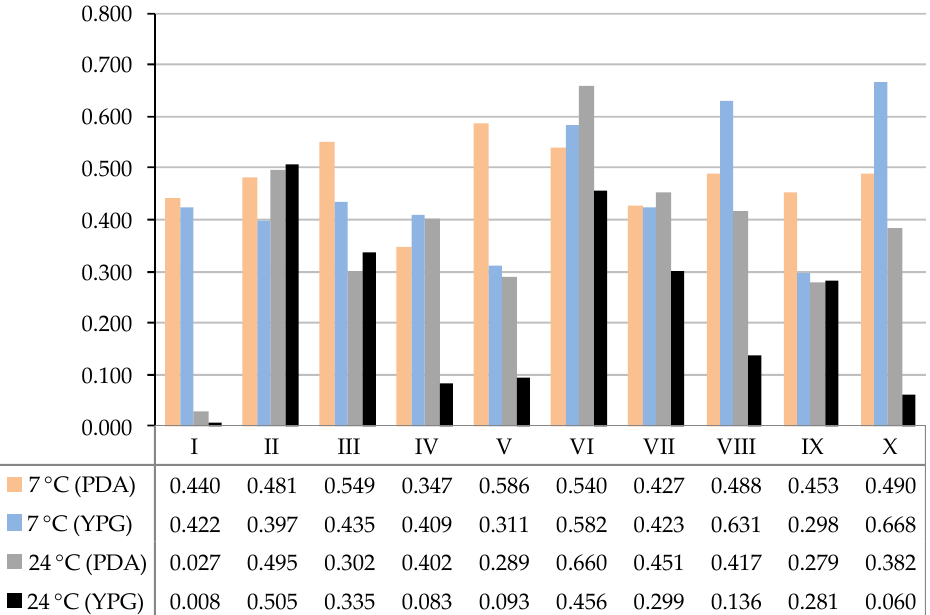
Figure 8. The values of the Shannon Diversity Index calculated to determine the diversity of fungal communities from specific research sites: I–X—study